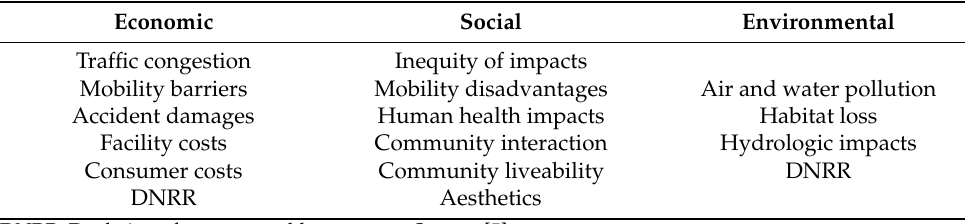
Table 1. Impact of transport upon sustainability